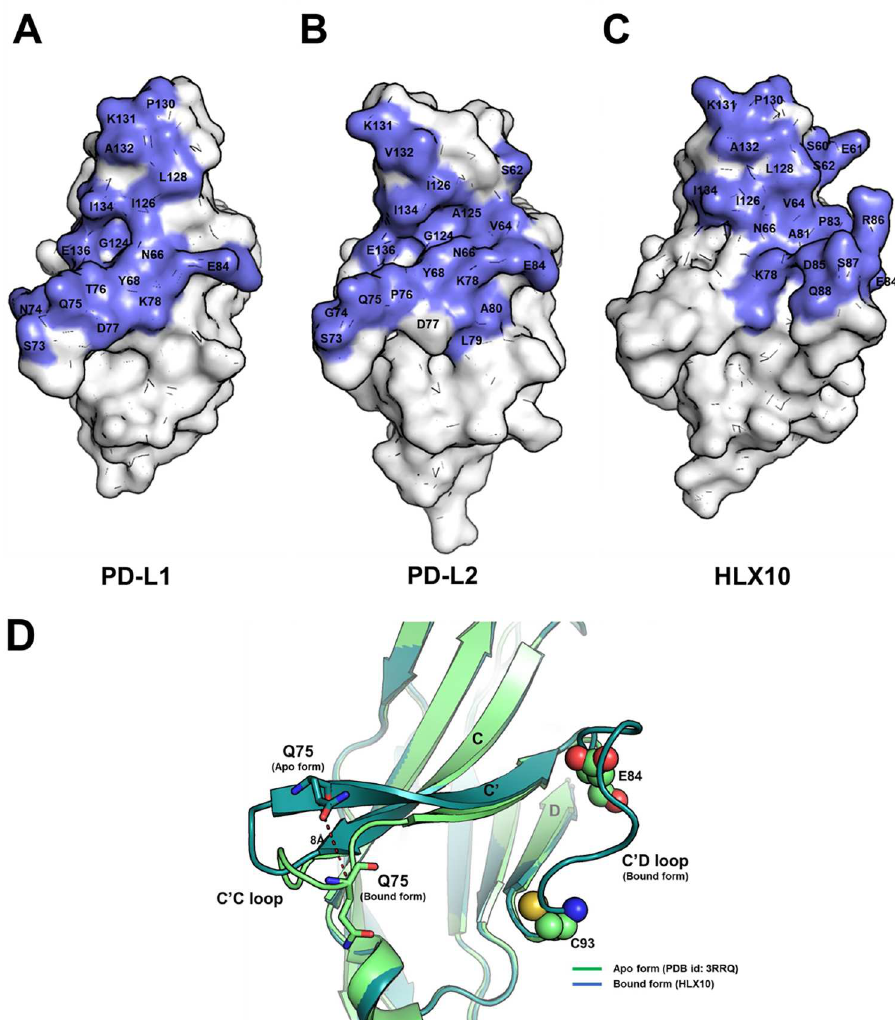
Fig 10. Binding epitope of HLX10 overlaps with PD-L1 and PD-L2. (a-c) Comparison of binding interface of PD-L1, PD-L2 and HLX10. hPD-1 is represented as white surface with binding interface of binders (PD-L1, PD-L2 and HLX10) colored in slate. The C’D loop of hPD-1 is missing in hPD-1/hPD-L1 (PDB: 4ZQK) and hPD-1/hPD-L2 structures (PDB: 6UMT) because of structure flexibility. (d) rearrangement of CC’ loop of hPD-1 for HLX10 binding. C α atom of Gln75 displays an 8 Å movement. Except C’C loop of hPD-1, there is no significant conformational change between apo and bound form of hPD-1 structures (overall backbone RMSD = 0.351 Å ). The C’D loop is missing (D85-D92) in apo form hPD-1 structure (PDB: 3RRQ) because of structure flexibility. HLX10 shows an opposite heavy chain (HC) and light chain (LC) usage compared to Pembro. As previously described, Nivo binds PD-1 by using the N-terminal extension, FG and BC loops as a mode for binding, while the overlapping binding surface shared by the VH region of HLX10 and PD-L1 resides mostly on the FG and C’Ds loops. Furthermore, since our construct design of hPD-1 (W32-P160), does not contain the N-terminal loop (L25-R30), it suggests that the N terminal loop is not essential for HLX10 binding. In contrast, the interaction of Pembro with hPD-1 is heavily dependent on the flexible C 0 D loop of PD-1, demonstrating that HLX10 epitope is more similar to pembro than Nivo. As summarized in Table 3, HLX10 binds shared several residues with Pembro and Nivo. Furthermore, HLX10’s epitope region shows a much